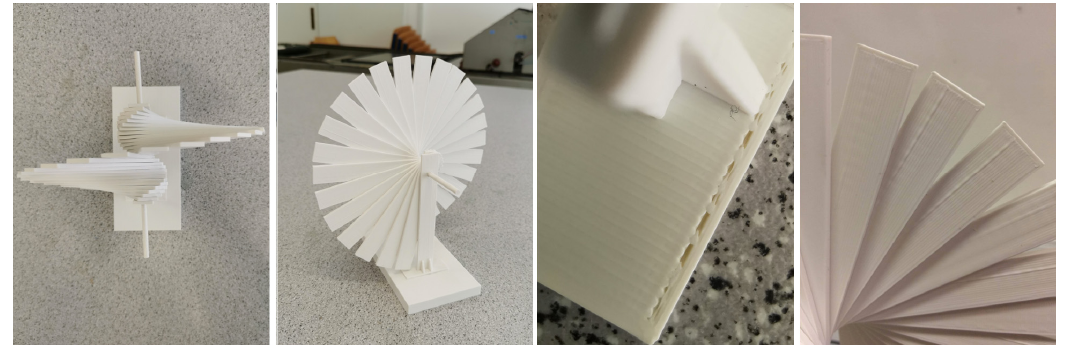
Figure 11. Three-dimensional printed parts of the sculpture Transition and the process of its as- sembly.